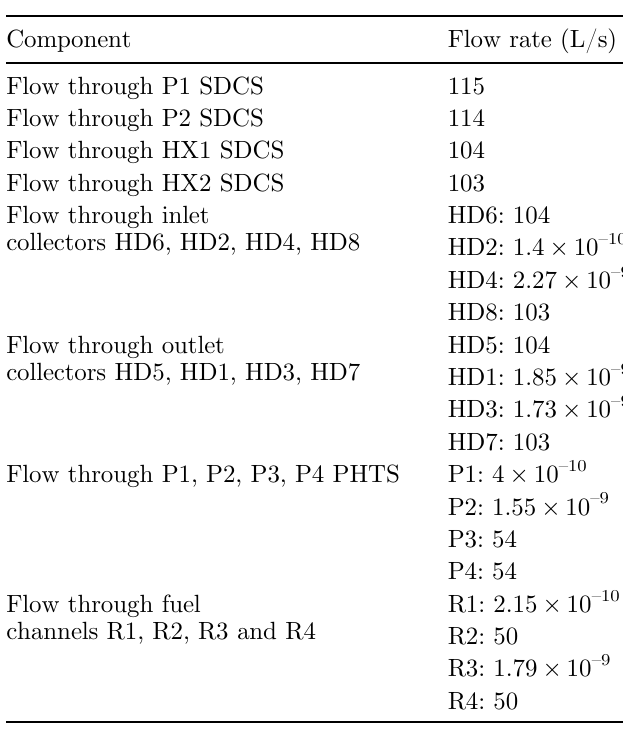
Fig. 2. Examination for 2 HX for cooling agent 30 °